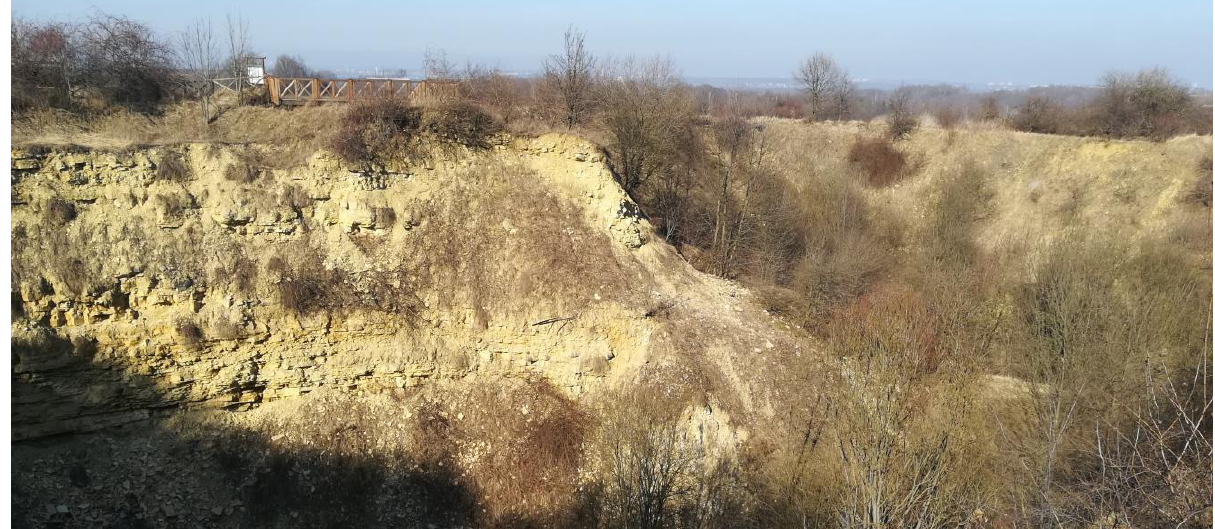
Fig. 3. One of the limestone quarries in Mikołów Mokre (author’s own photo